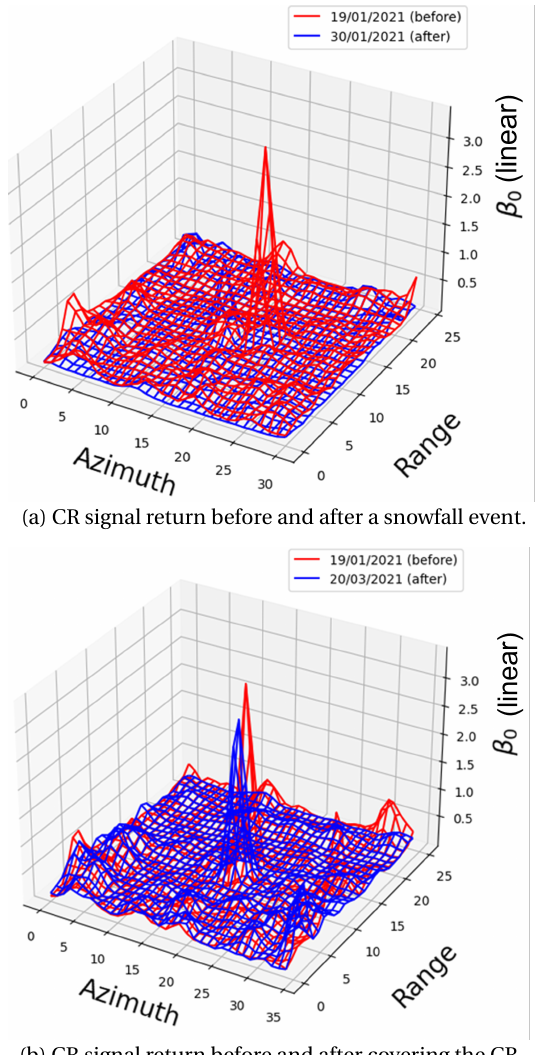
Figure 4. Tests in the Chamonix valley to check CR performance in Sentinel-1